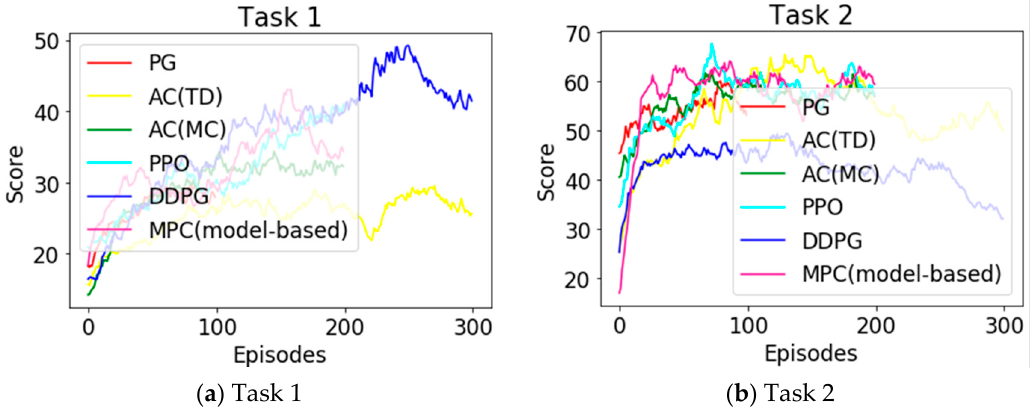
Figure 10. Performance comparison curves of the six reinforcement learning algorithms.